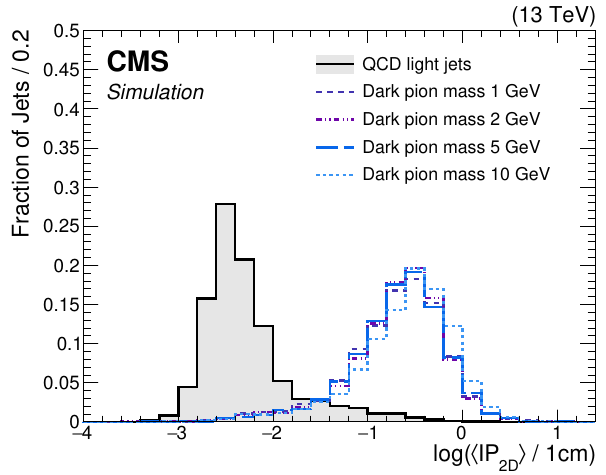
Figure 2 . Distributions of h IP i for background (black) and for signals with a mediator mass of 2D 1 TeV and a dark pion proper decay length of 25 mm, for various dark pion masses.